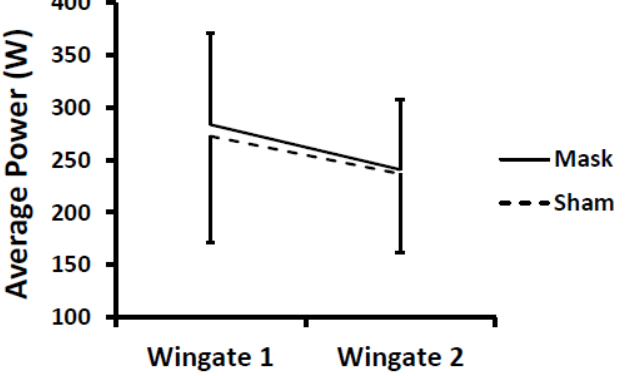
Figure 3. Change in average power during repeated Wingate tests for mask and sham conditions. There were no differences between conditions. There was a time main effect ( p < 0.001) with Wingate 2 < Wingate 1. Values are means and error bars are SD.